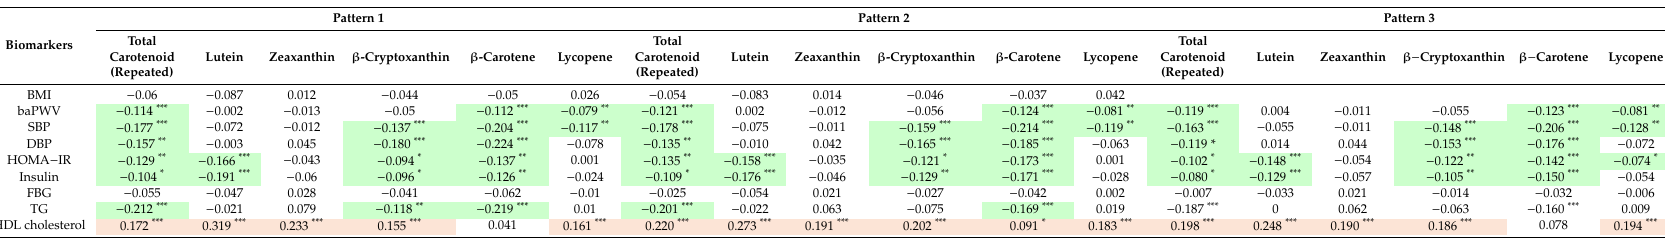
Table 4. Multiple linear regression analysis showing association between cardiovascular disease markers and each carotenoid’s concentration in the blood in males. Pattern1 Pattern2 Pattern3 Total Biomarkers Carotenoid (Repeated)